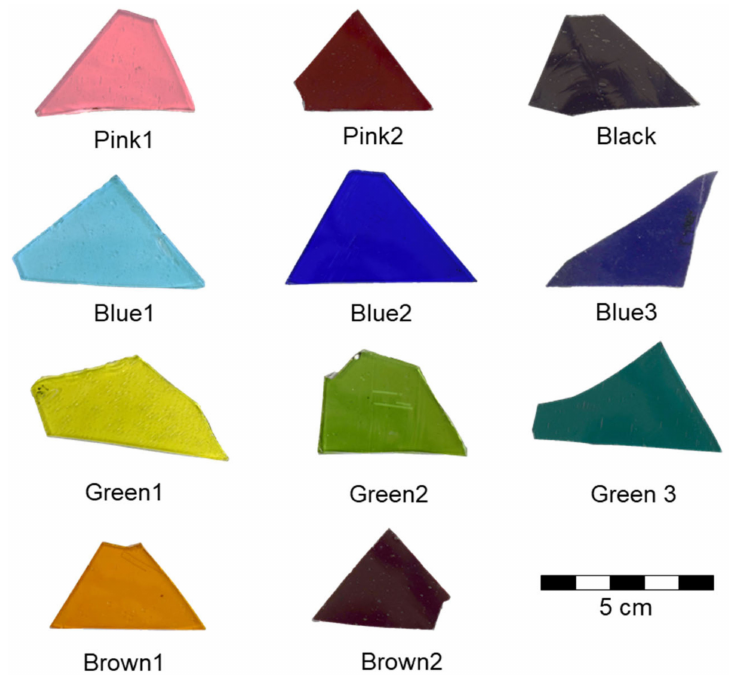
Figure 1. Images of the flashed glasses considered in the present study. Transmission spectra of original glasses were recorded with a Perkin Elmer